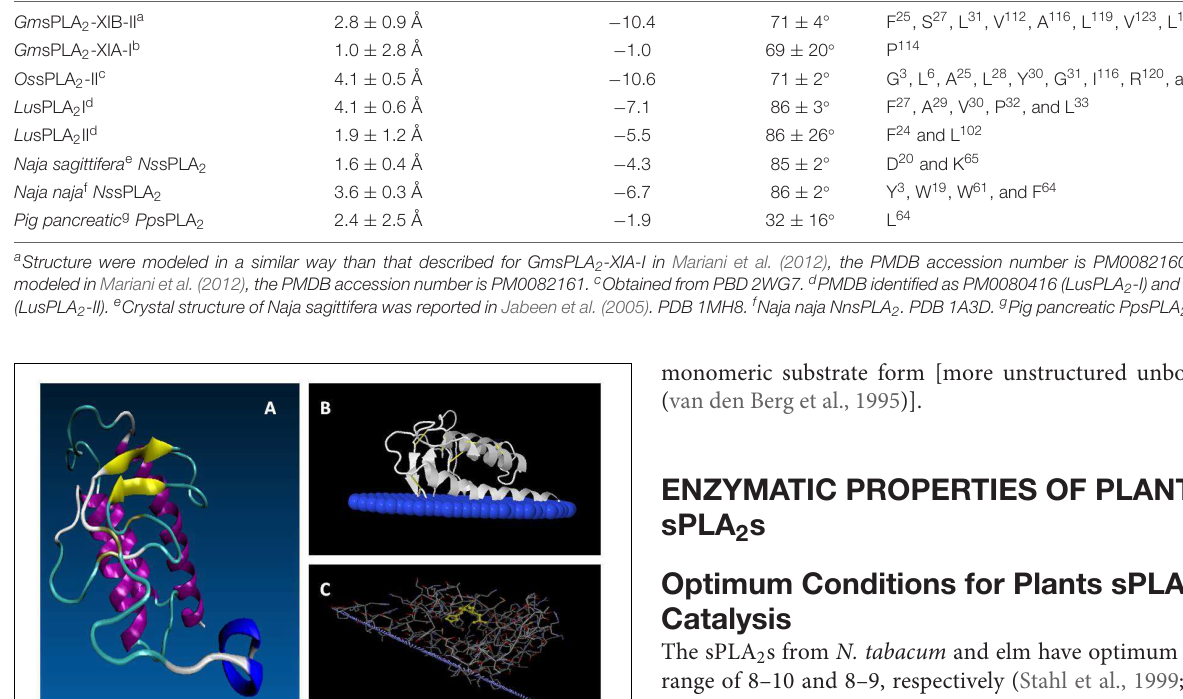
TABLE 6 | Orientation of different sPLA 2 s at the membrane interface. Protein Depth/hydrophobic thickness